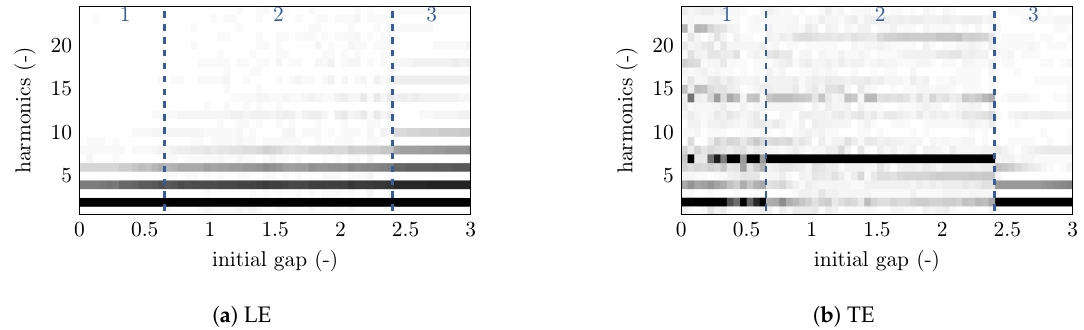
Figure 28. Evolution of the space Fourier transform of the wear profile with the initial clearance for the LP compressor blade.